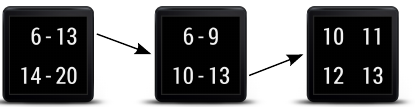
Fig. 2. Example for entering a number using the Range Input